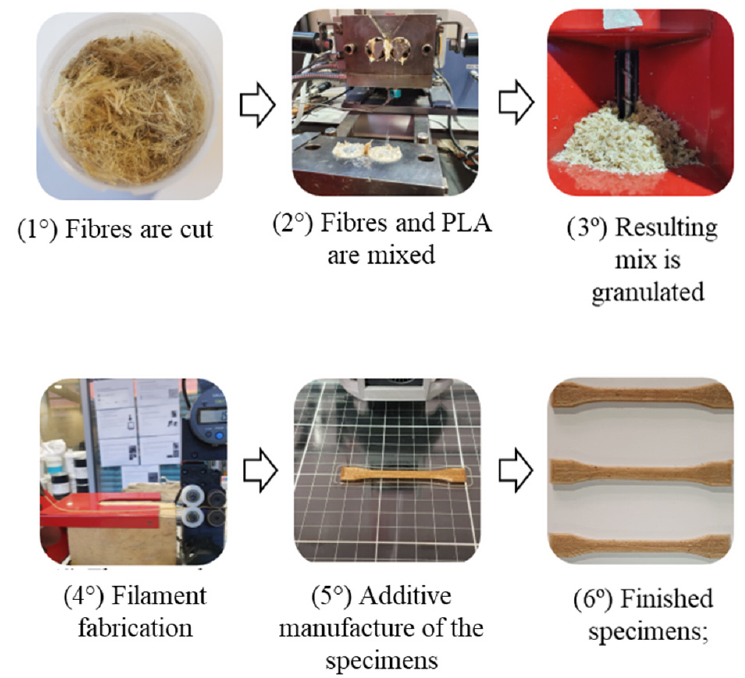
Figure 2. Schematic representation of the specimen fabrication.